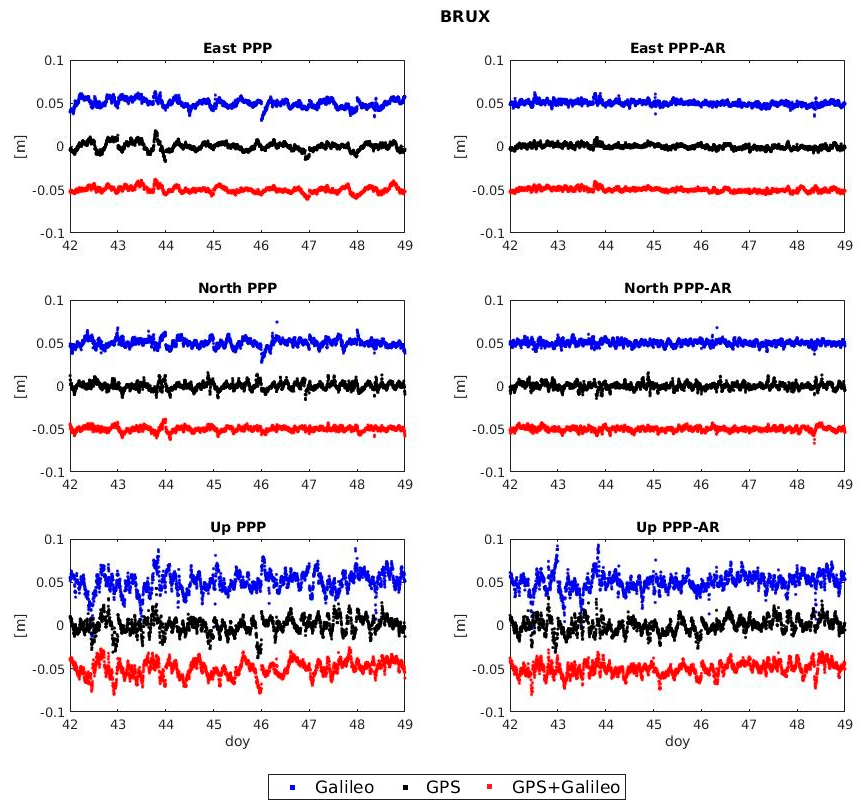
Figure 2. PPP and PPP-AR solutions for BRUX station for Galileo-only, GPS-only and Multi-GNSS for the period 11–19 February 2019, DOY: 42–49 / 2019. For Galileo-only and GPS + Galileo, additional biases of + 0.05 m and − 0.05 m have been added respectively for better representation in the graph. Table 3. Ambiguity resolution percentages for Galileo and GPS system for BRUX station.